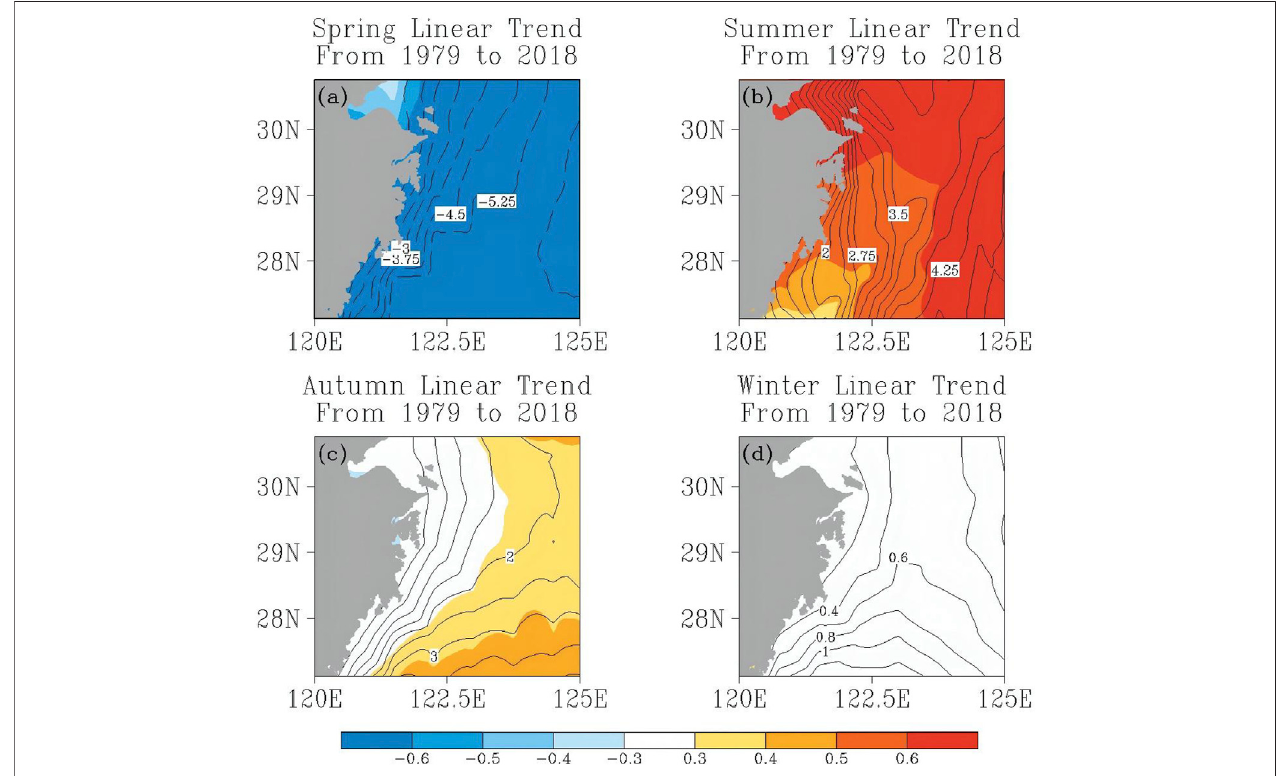
FIGURE 10 | Seasonal trend of wind power density (the contour line is the tendency value, the shaded part is the area put through the signi fi cance test): (a) the spring linear trend; (b) the summer linear trend; (c) the autumn linear trend; (d) the winter linear trend.